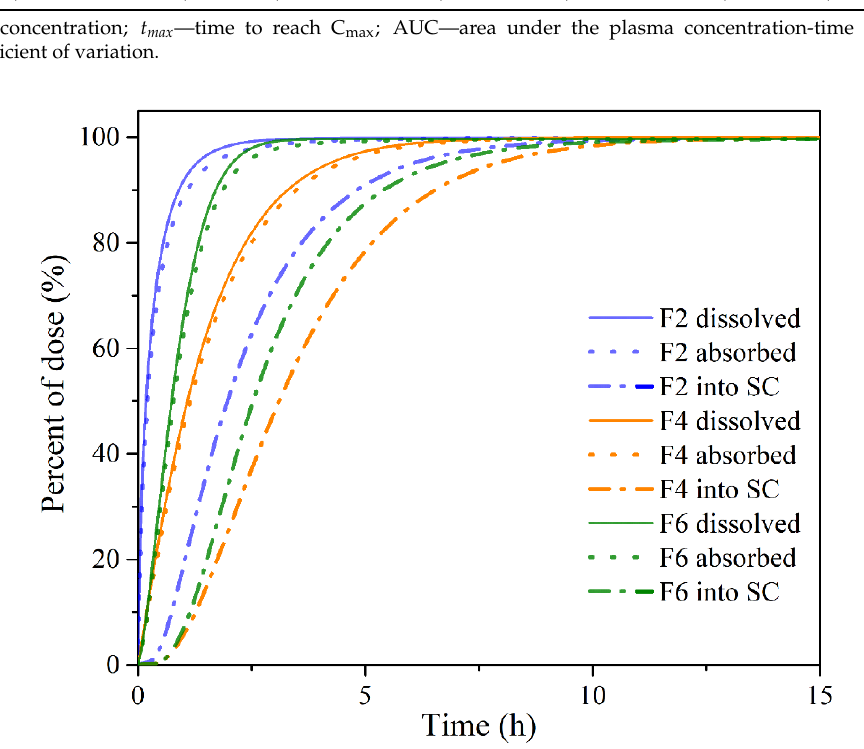
Figure 7. Predicted cumulative percent of PRH dissolved, absorbed, and entered into system circulation (SC) following single-dose administration of the tested buccal films.